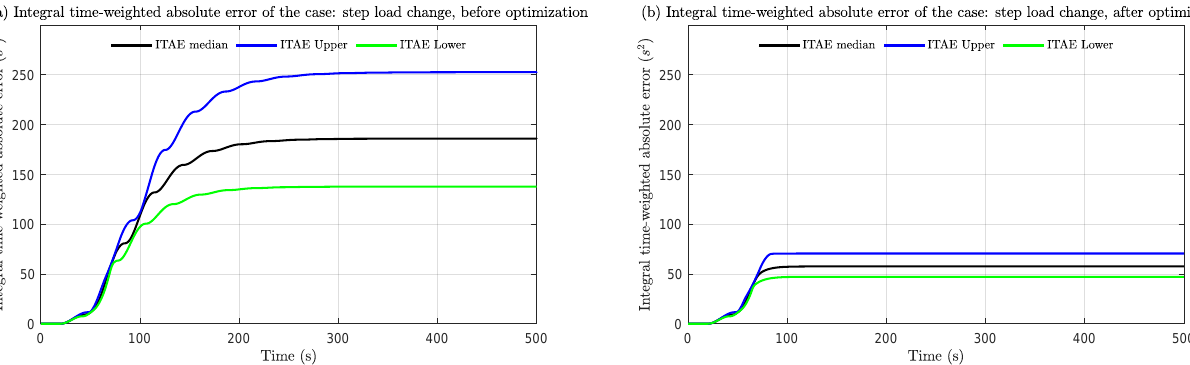
Figure 18. Integral time-weighted absolute error of the case of step load change: ( a ) before optimization; ( b ) after optimization.